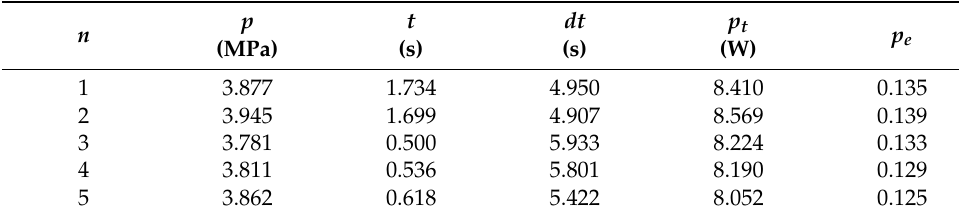
Figure 21. Sets of Pareto solution. Table 4. Part of Pareto solution sets.